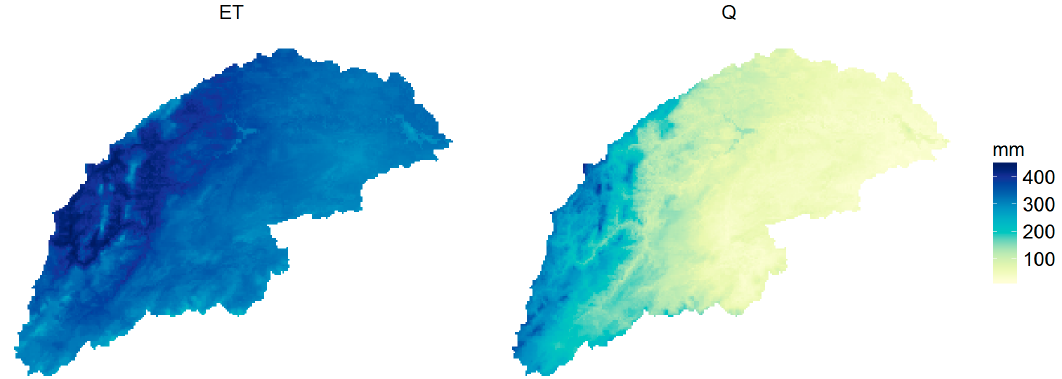
Figure 3. Maps of mean annual evapotranspiration and streamflow based on simulated outputs of the NDVI-based reference model (mm).